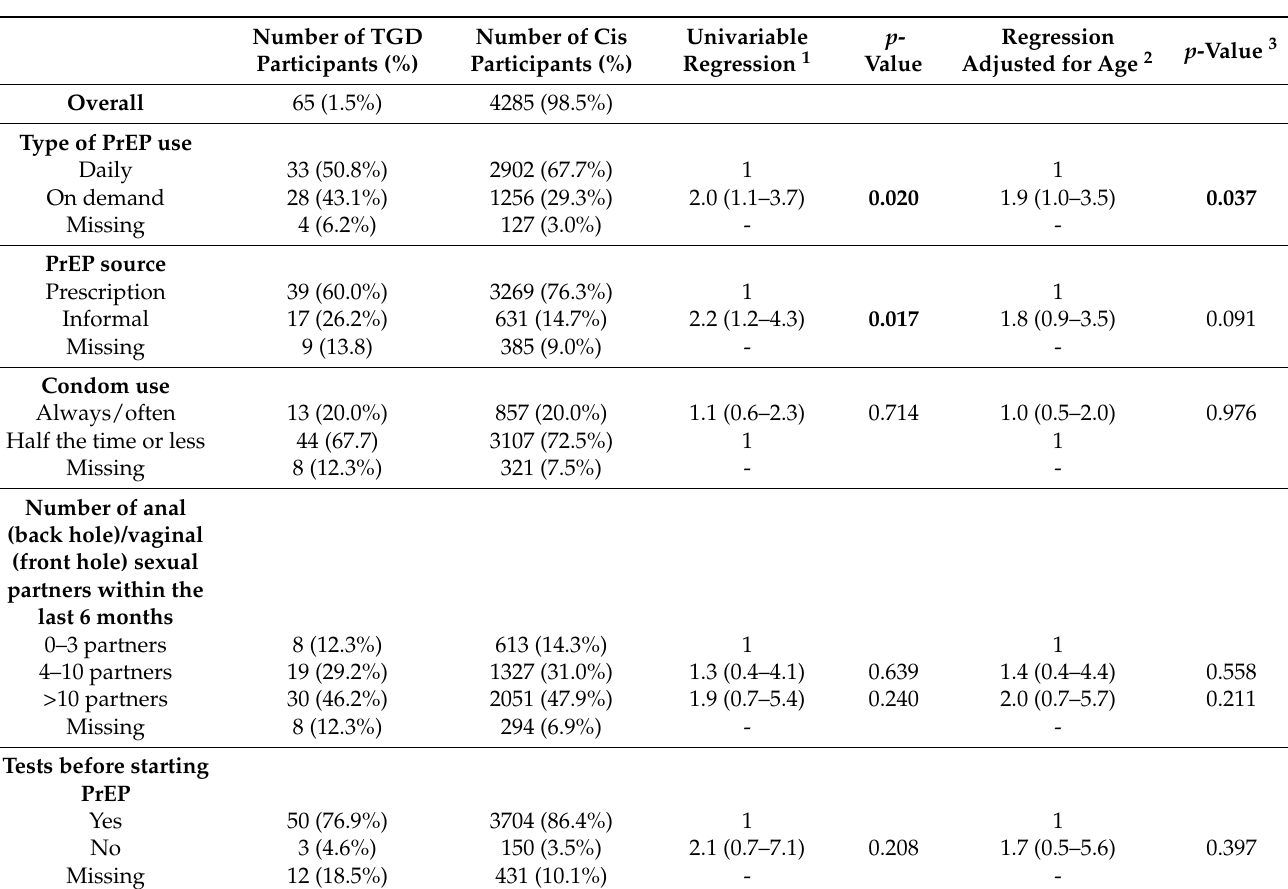
Table 2. Pre-exposure prophylaxis (PrEP) use and sexual behaviour of trans/gender diverse (TGD) and cis male PrEP users ( n =